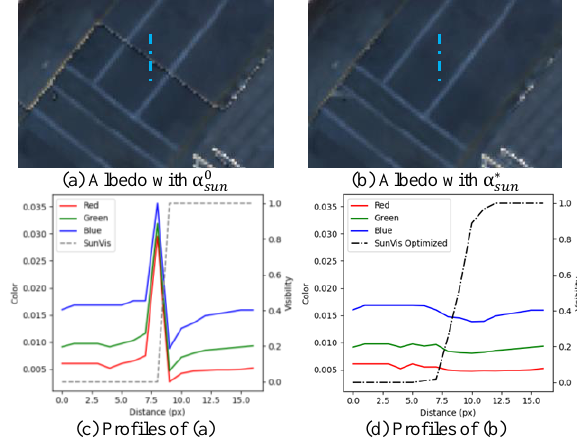
Figure 9. (a) and (c) are the decomposed albedo with binary